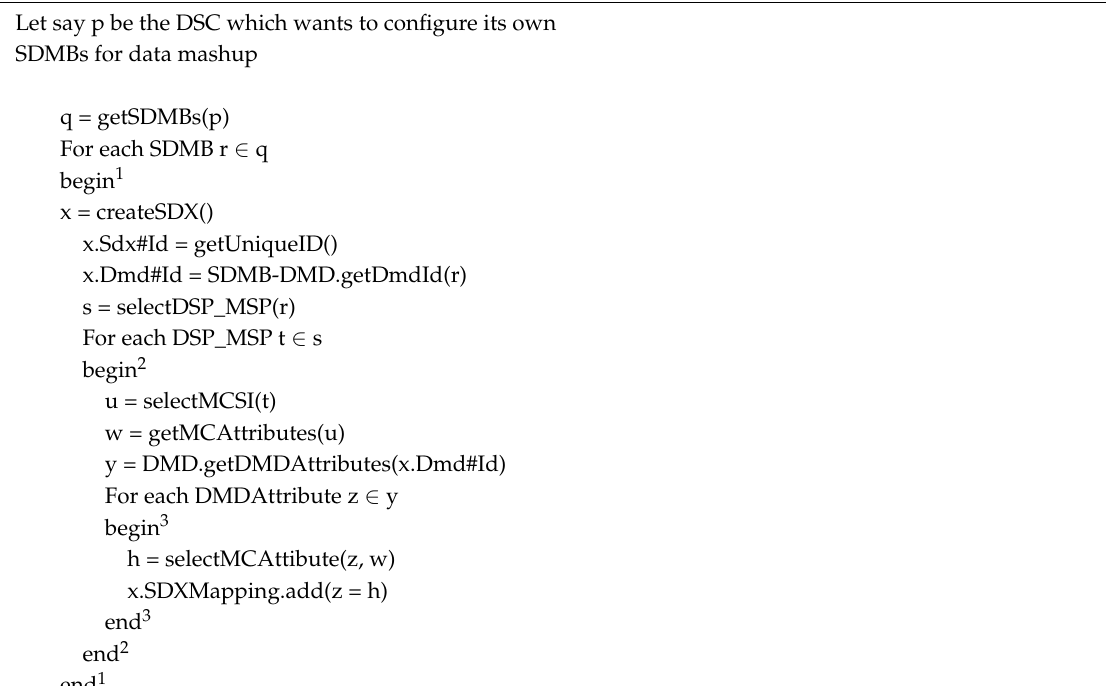
Algorithm 1. One Time Mashup Configuration Algorithm